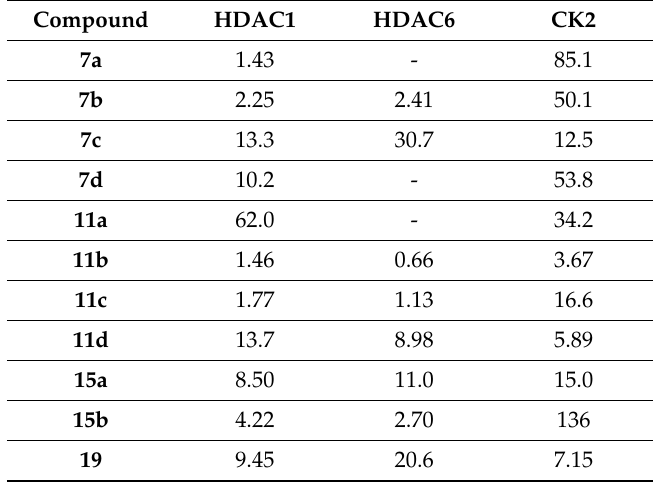
Table 1. Inhibitory activity (IC 50 ( µ M)) on HDAC1, HDAC6 and